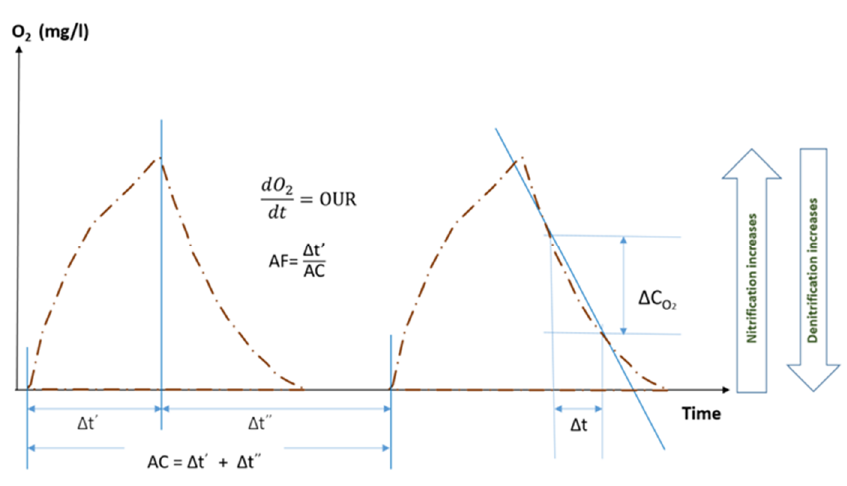
Figure 3. Dissolved oxygen (DO) profile during intermittent aeration (AF = Aeration fraction, AC = Aeration cycle, OUR = Oxygen utilization rate) [20].